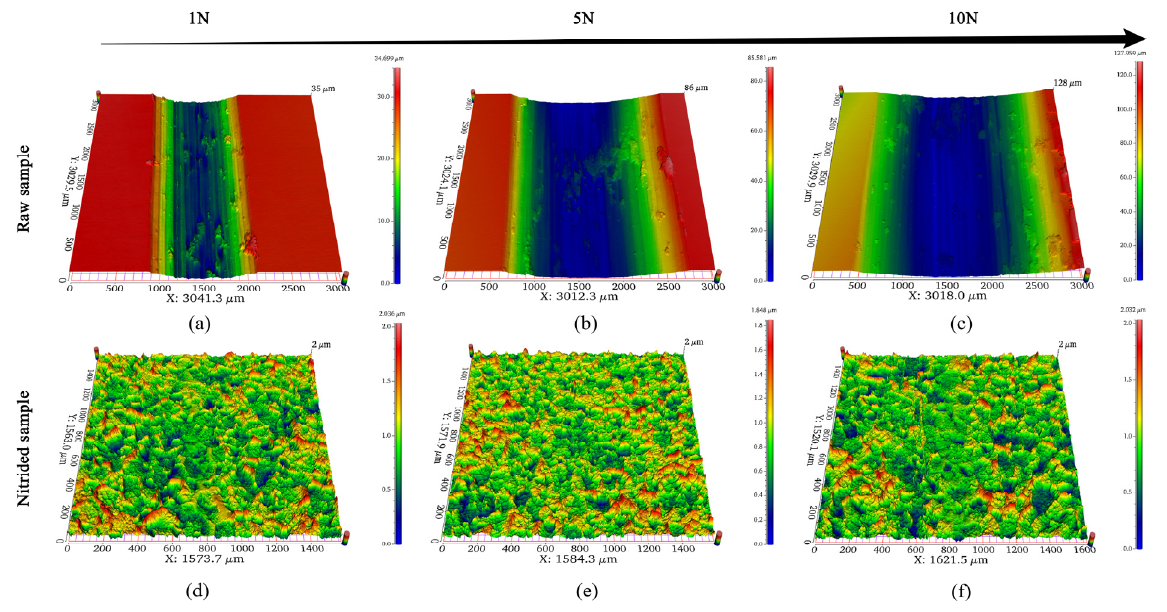
Figure 8. 3D wear morphology after the tribocorrosion test of the ( a–c ) raw sample and the ( d–f ) nitrided sample at cathodic applied potential (E = − 1.2 V) in SBF solution.